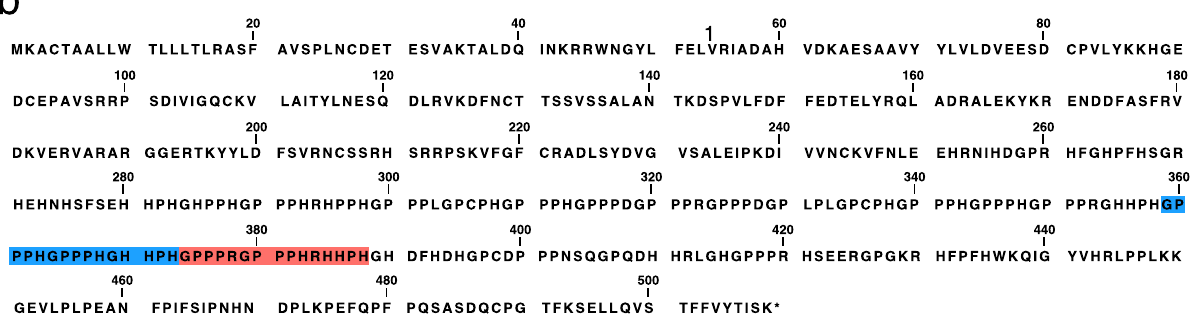
Figure 2. Nucleotide and deduced amino acid sequences of e HRG gene. ( a ) Nucleotide sequence of cloned e HRG gene. 45 bp deletion: red highlighting area; 90 bp deletion: blue and red highlighting area. ( b ) Deduced amino acid sequence of e HRG . 15 amino acid deletion: red highlighting area; 30 amino acid deletion: blue and red highlighting